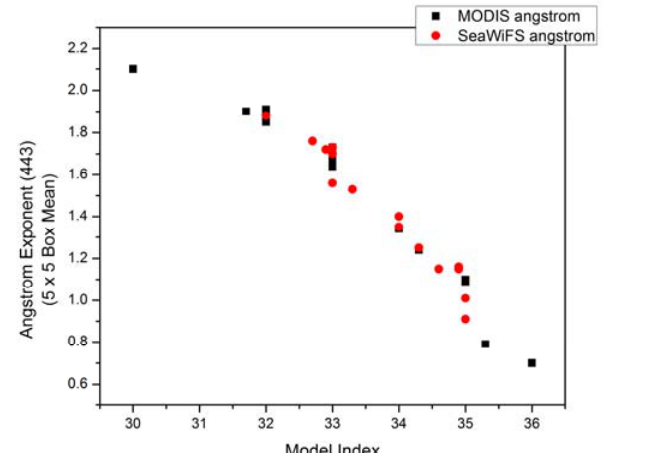
data sets seen in Table t